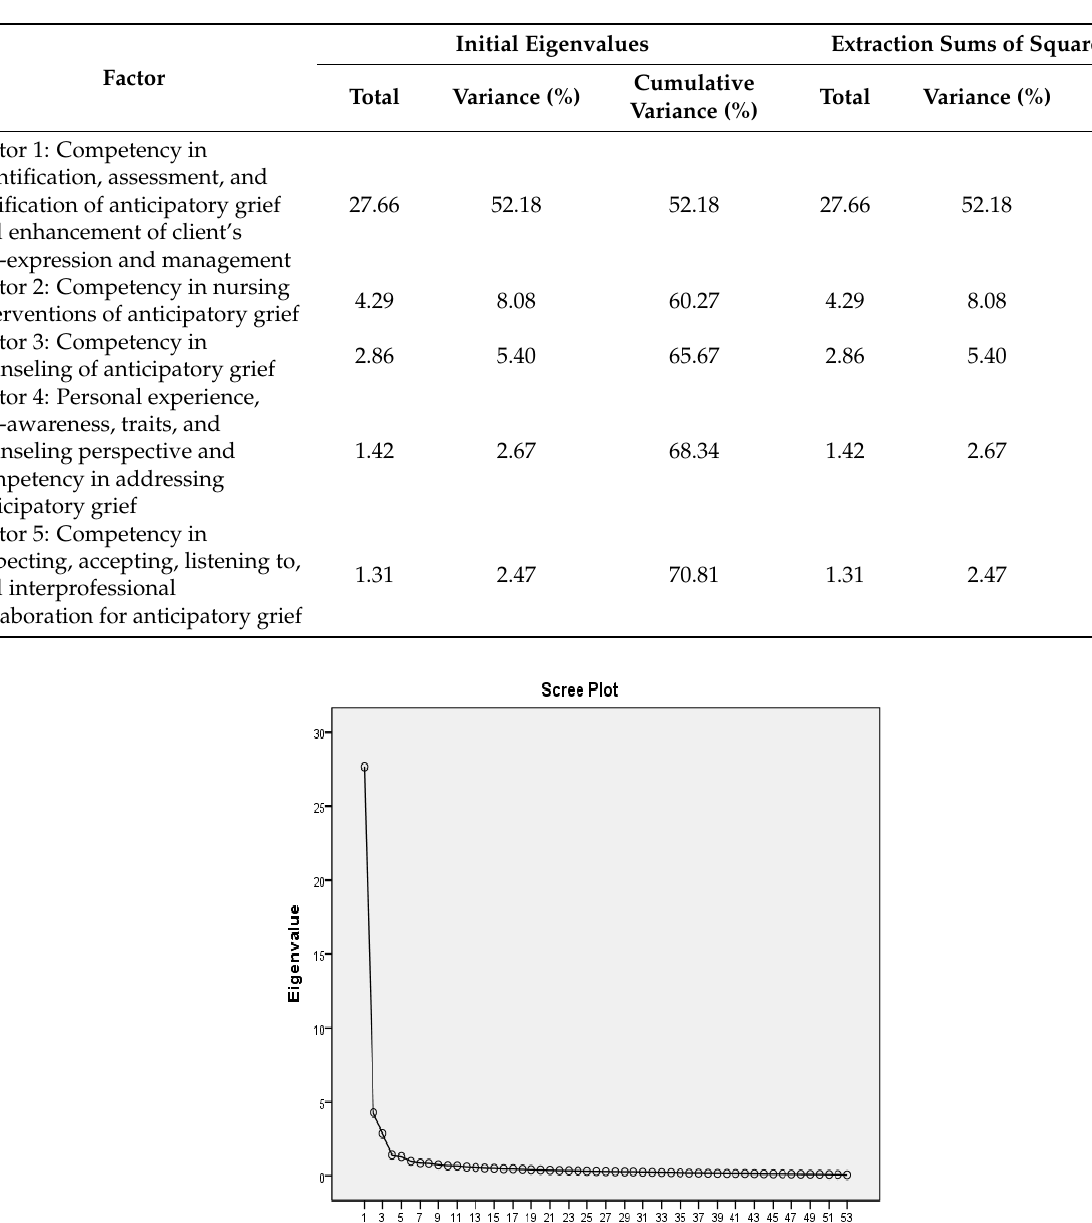
Table 1. Total variance explained by the five factors of the Anticipatory Grief Counseling Competency Scale (n = 251).